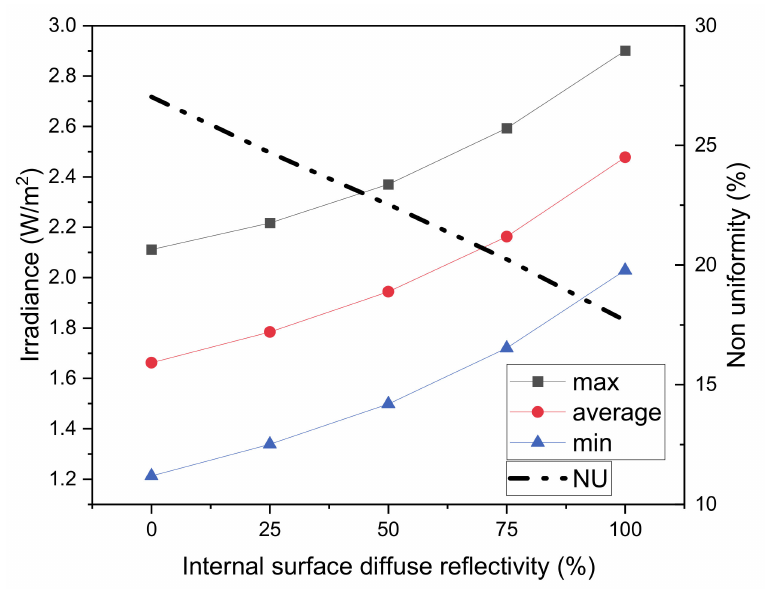
Figure 9. Irradiance and non-uniformity parameter (NU) as a function of internal surface reflectivity.